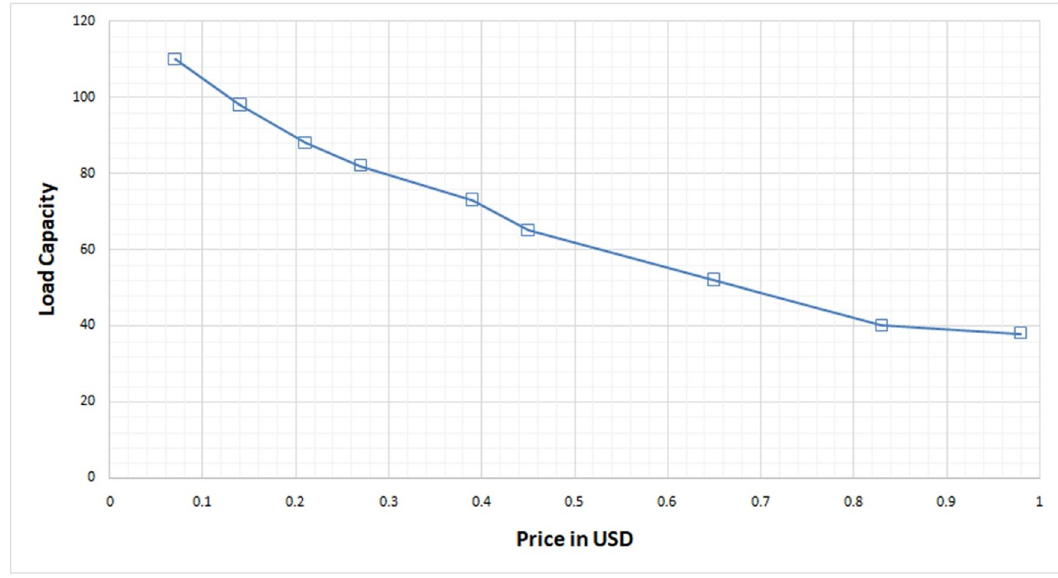
Fig 8. Price value computed for load